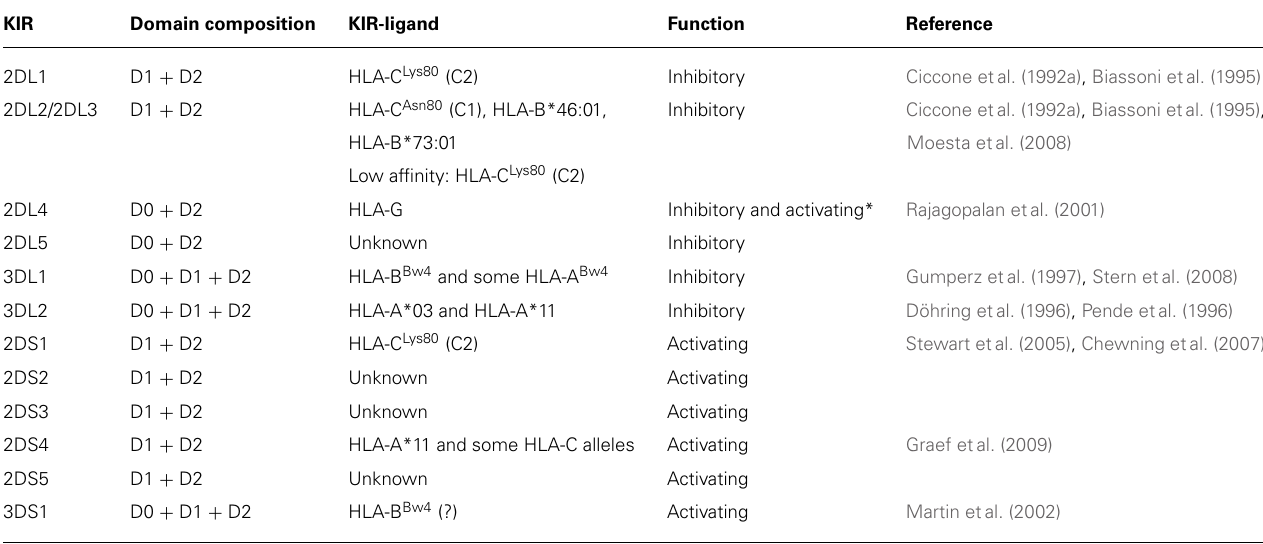
Table 1 | KIRs and